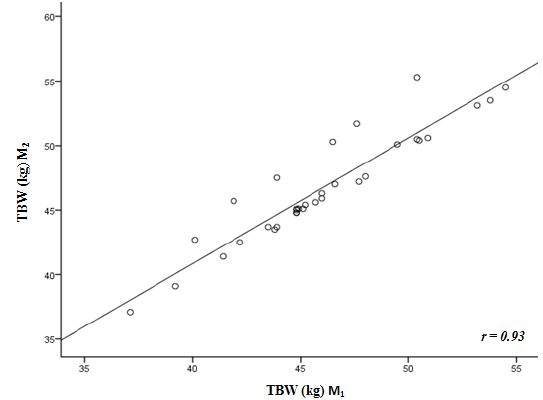
Figure 11. Correlation between the values of param- eters measured by Nutriguard-M before and after the intake of fluids – body cell mass